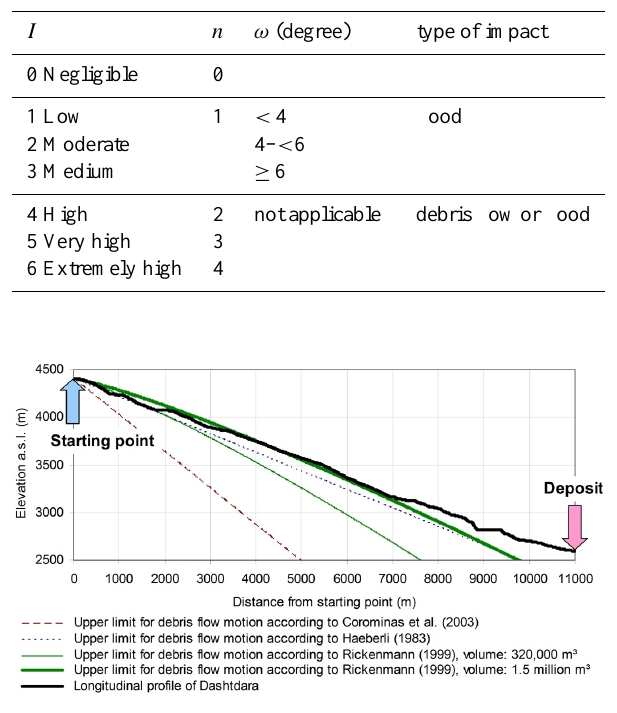
Fig. 5. Longitudinal profile of the flow path of the Dasht 2002 event with the upper limits of the flow paths according to different empir- ical relationships.